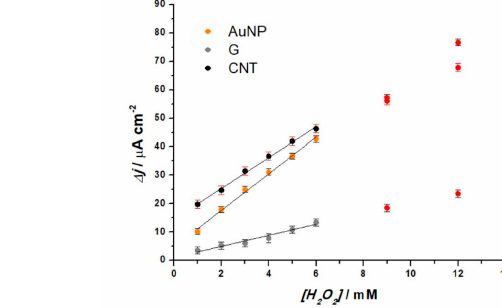
Figure 2. ( a ) pH study-data from CV in 0.1 M NaPB with extract and 6 mM H 2 O 2 addition, v = 50 mV s − 1 and ( b ) Calibration plots recorded at 0.55 V vs. Ag/AgCl in 0.1 M NaPB with extract, pH = 7.0.